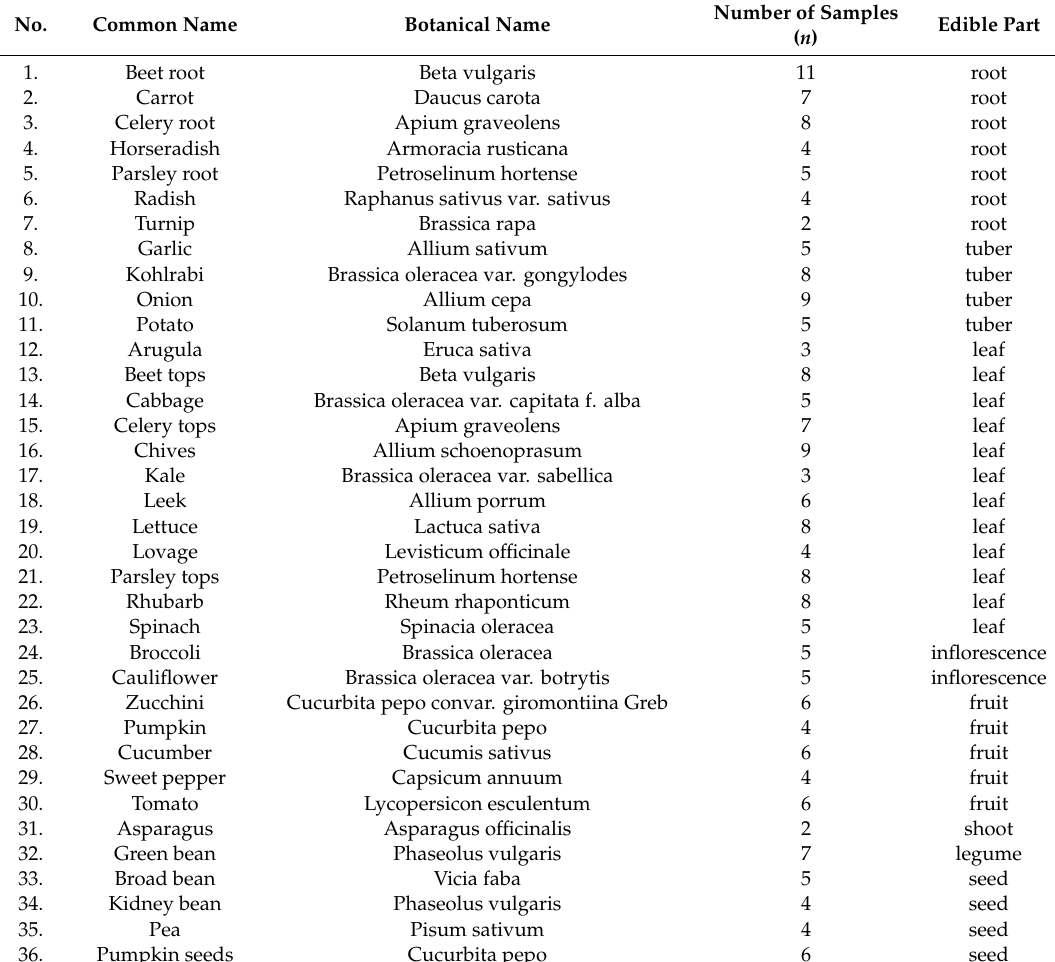
Table 1. Description of the vegetables investigated in this